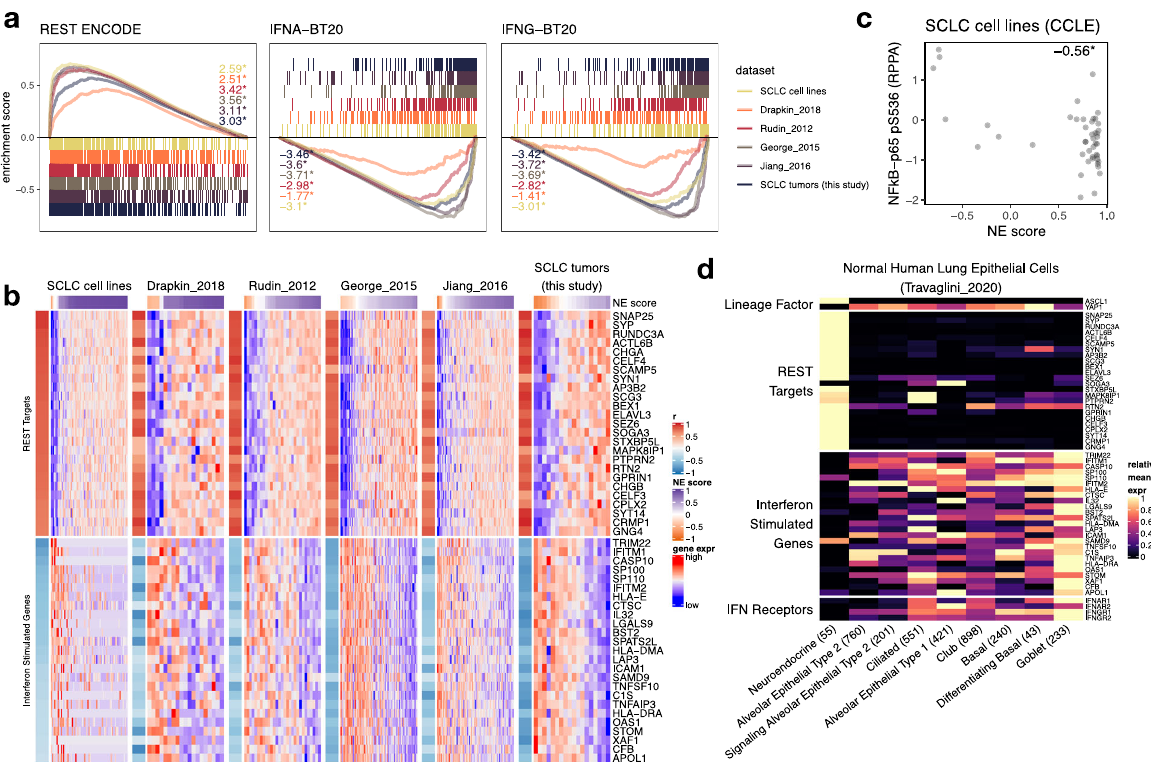
Fig. 2 Repression of ISGs in high NE-score SCLC and PNECs. a GSEA enrichment plots for selected gene sets. Results from SCLC cell lines, PDXs (Drapkin_2018), and patient tumor data sets were superimposed. Normalized enrichment score (NES) was provided. *, multiple comparison-adjusted p -value < 0.05. b Heatmaps for top 25 leading-edge genes selected from gene sets in a . Gene expression matrix of each data set was annotated with color- coded Pearson correlation coef fi cient (from correlating NE score with gene expression) as a left-side column, and a top bar indicating NE scores. For each data set, gene expression was z -score standardized across samples. c Scatter plot showing negative correlation between NE score and Ser536 phosphorylation on NFkB-p65 in SCLC cell lines. Pearson correlation coef fi cient was provided. * p -value < 0.05. d Heatmap showing relative expression of selected lineage factors ( ASCL1 and YAP1 ), REST targets, and ISGs (same genes as used in b , determined from a ) as well as interferon receptor genes in healthy human lung epithelial cells based on scRNA-seq experiments. Gene expression from all cells in each cell-type cluster was averaged and then min – max scaled across cell types to a scale between 0 and